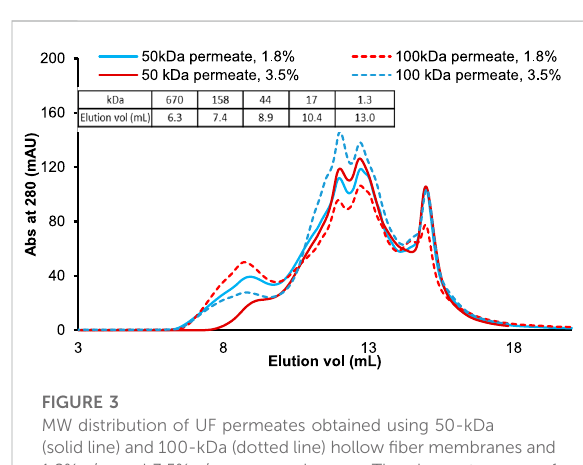
FIGURE 3 MW distribution of UF permeates obtained using 50-kDa (solid line) and 100-kDa (dotted line) hollow fi ber membranes and 1.8% v/w and 3.5% v/w enzyme dosages. The chromatograms